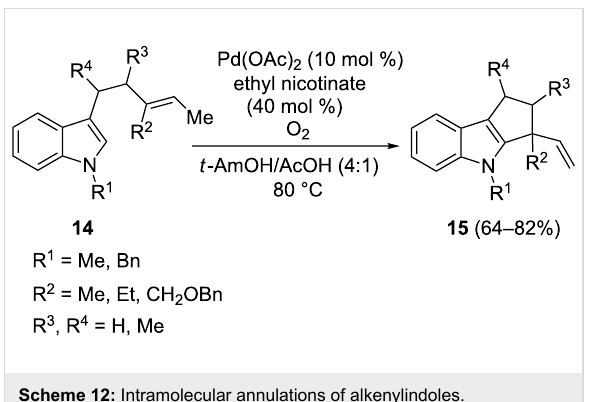
Scheme 12: Intramolecular annulations of alkenylindoles.